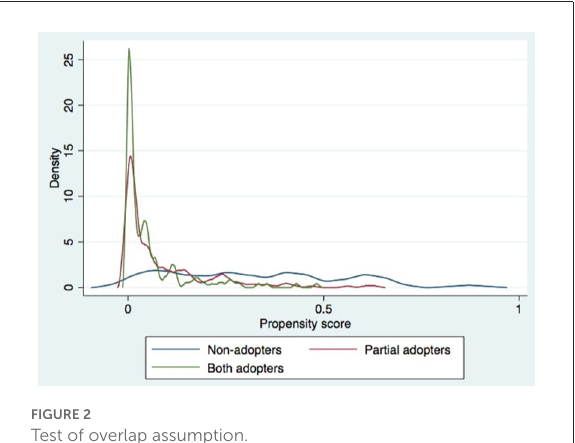
FIGURE2 Test of overlap